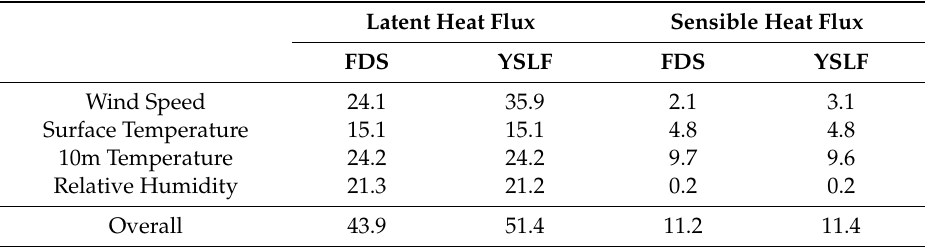
Table 2. Standard deviation of the LHF and SHF products (in W m 2 ) when factoring in uncertainties from CYGNSS L2 winds and MERRA-2 variables. Standard deviations from the uncertainties of the individual flux components (wind, temperature, humidity) are also